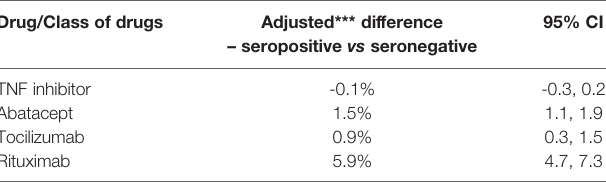
TABLE 2 | Adjusted differences in proportions with LUNDEX corrected clinical remission* for patients with seropositive** vs. seronegative RA, for different biologic